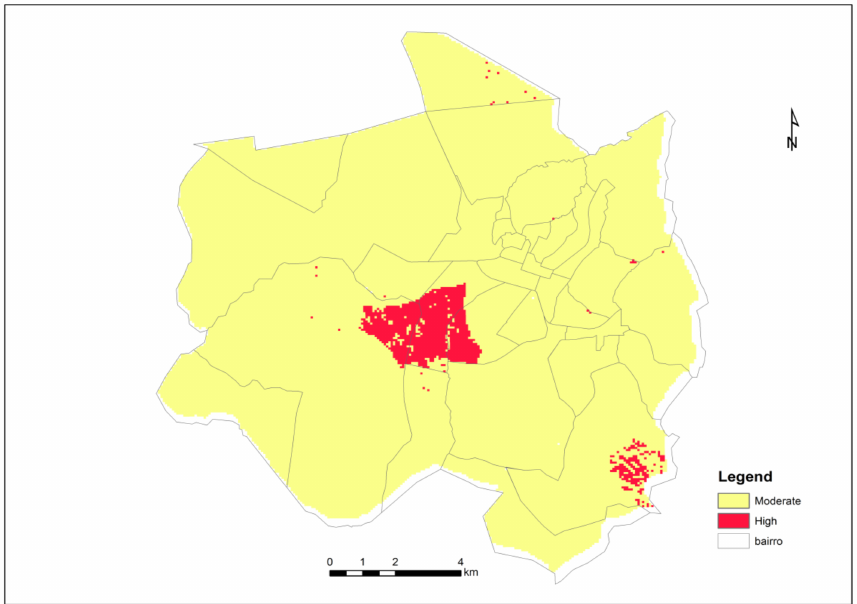
Figure 5. Chimoio risk map for